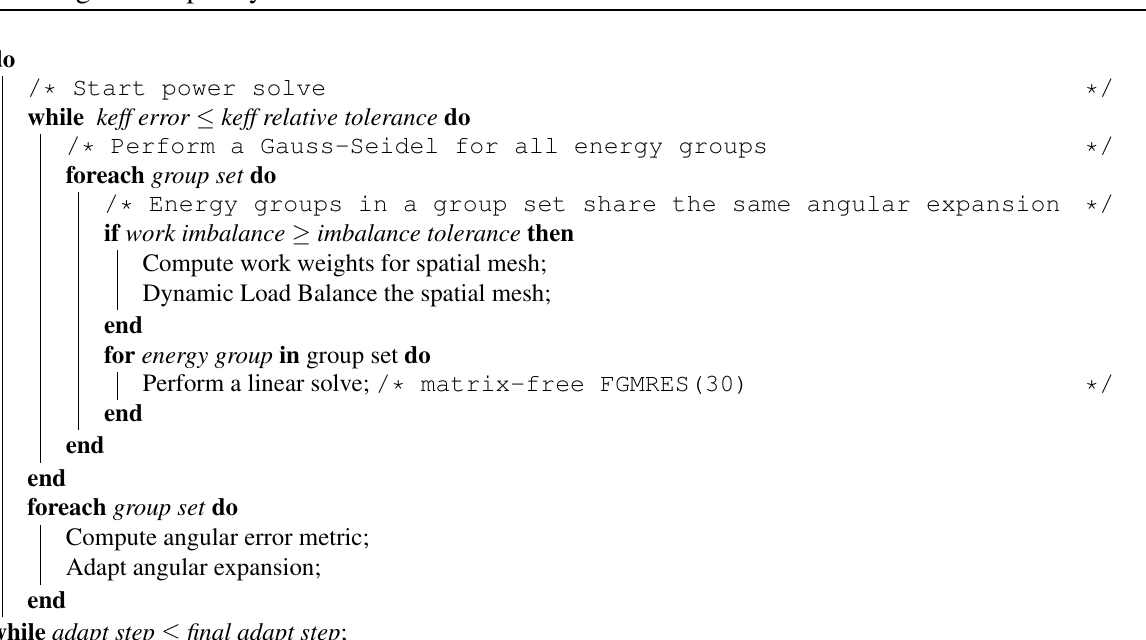
Algorithm 1: Dynamic Load Balancing algorithm of eigenvalue problems with energy